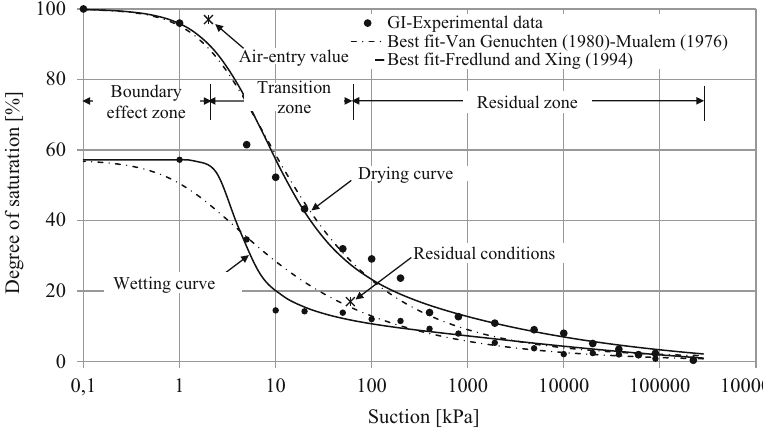
Figure 7: Soil – water characteristic curve ( SWCC ) , degree of saturation versus suction for GI soil.